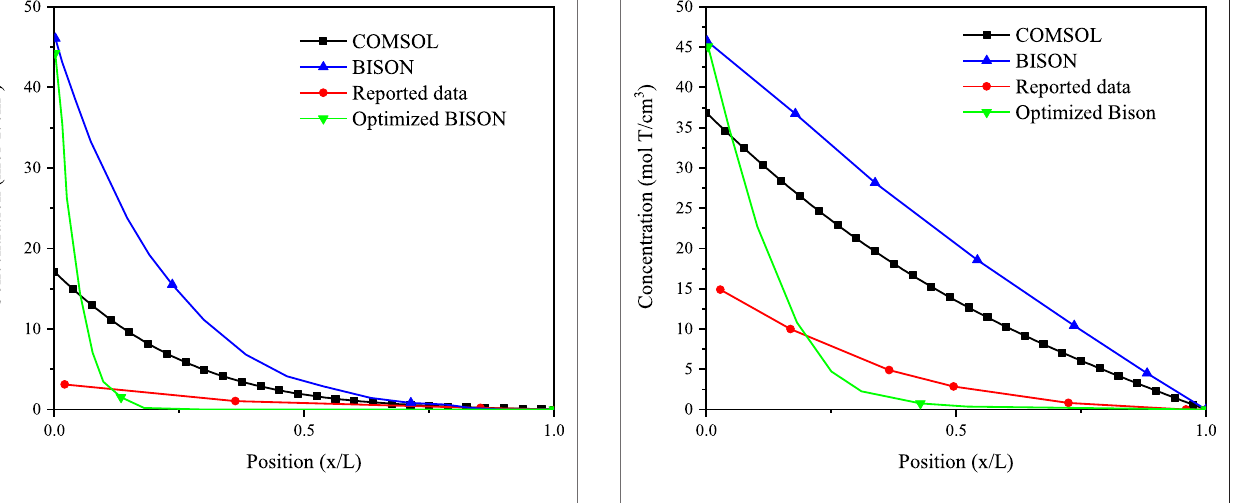
FIGURE 1 | Tritium distribution at the radial direction in the FeCrAl cladding of simulated and experimental results at 10,000 s, and concentrations are times 10 12 .